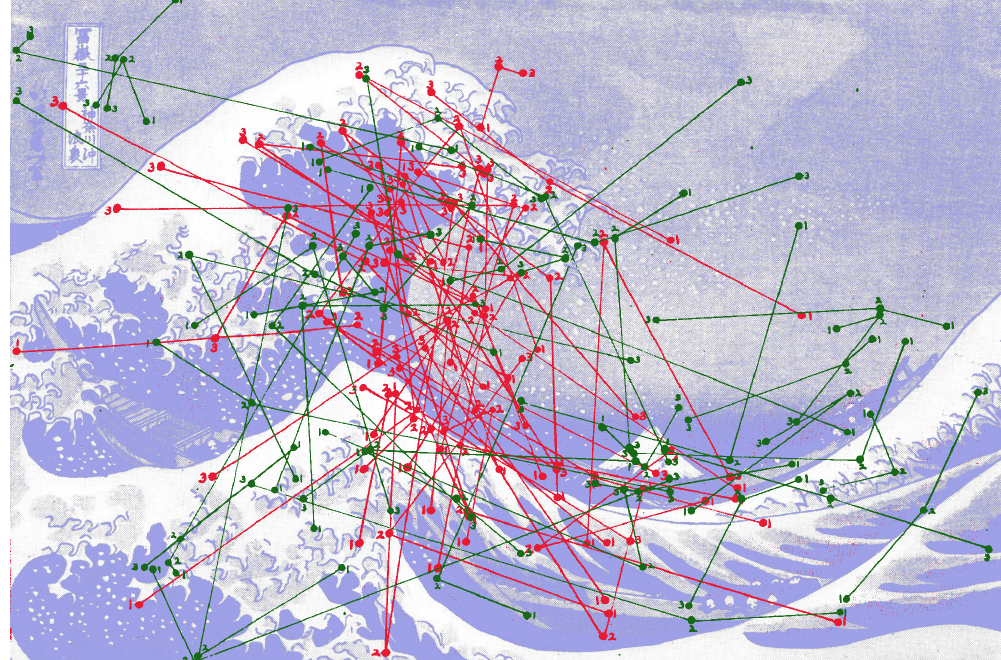
Figure 4 . Waves of eye movements 2 . Eye movement records when viewing The Wave by Hokusai. Each circle represents a fixa- tion made by an observer. The lines indicate the saccades that moved the eye from one fixation to the next. The first three fixations (numbered in sequence) from the start of viewing for 40 observers are shown in red and the final three fixations in green. (Adapted from Picture 13 and Plates XIV and XV in Buswell, 1935.)